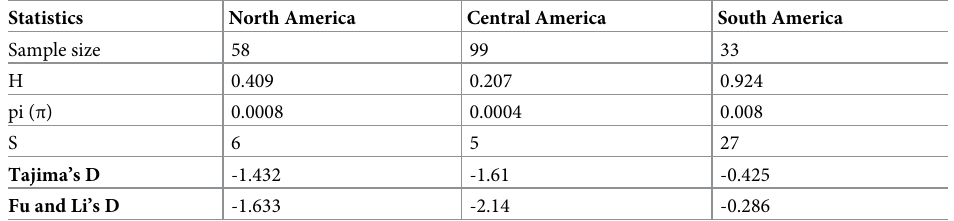
Table 1. Genetic diversity and neutrality tests for mtTcI clade by region.